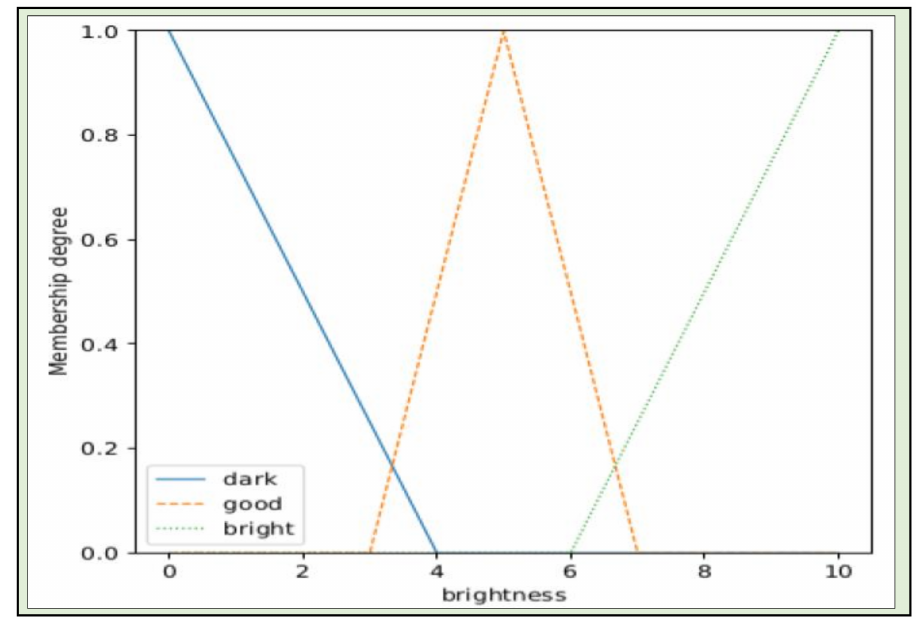
Figure 9. The fuzzy representation of